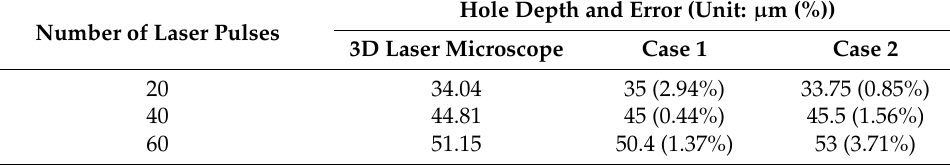
Figure 6. Image of the drilled hole after laser drilling for 60 pulses. ( a ) 3D confocal method; ( b ) cross-section; and ( c , d ) data from Cases 1 and 2, respectively. Table 1. Summary of experimental data.